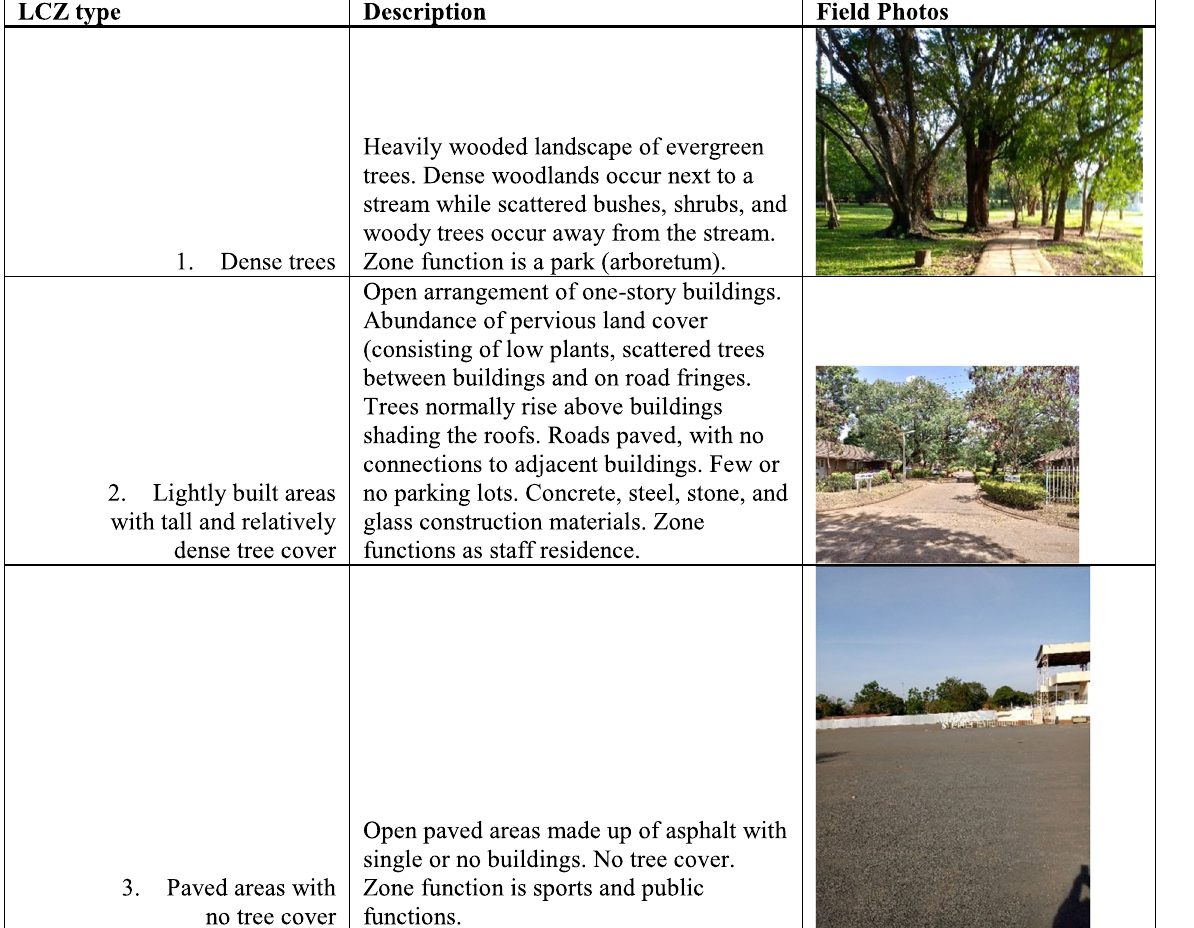
Table 7 Description of land cover features encountered during the traverse